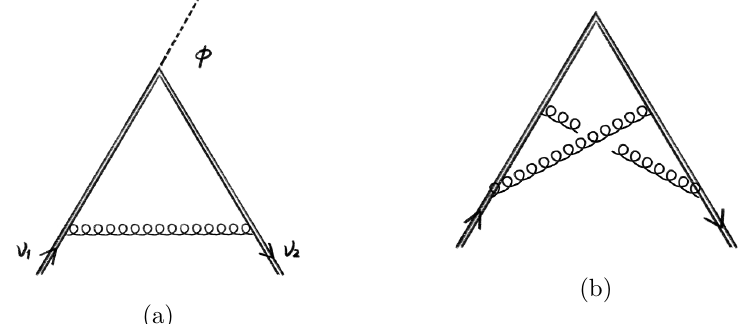
Figure 1. (a) One-loop Wilson line / heavy-quark effective theory diagram. (b) Example of a two-loop web diagram which has an overall divergence